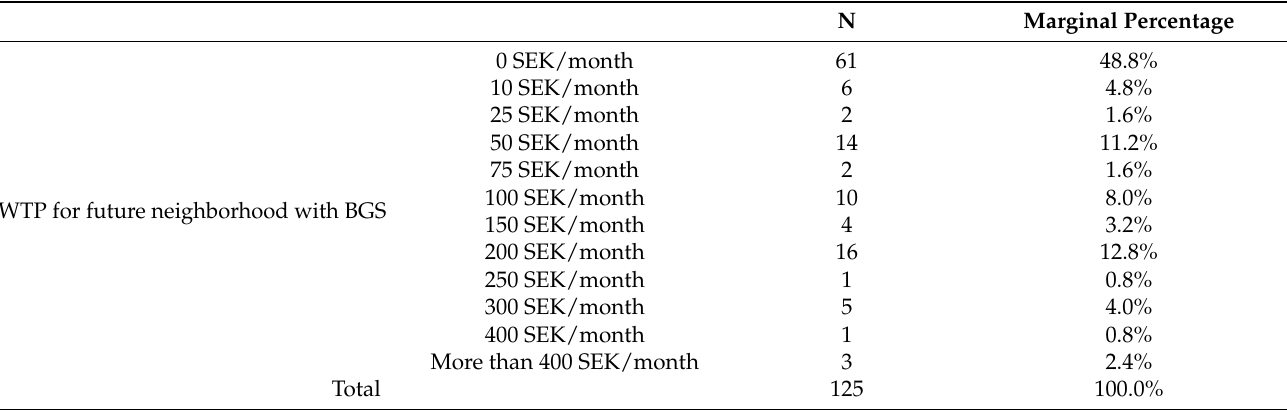
Table 4. Frequency table for willingness to pay for living in a neighborhood with